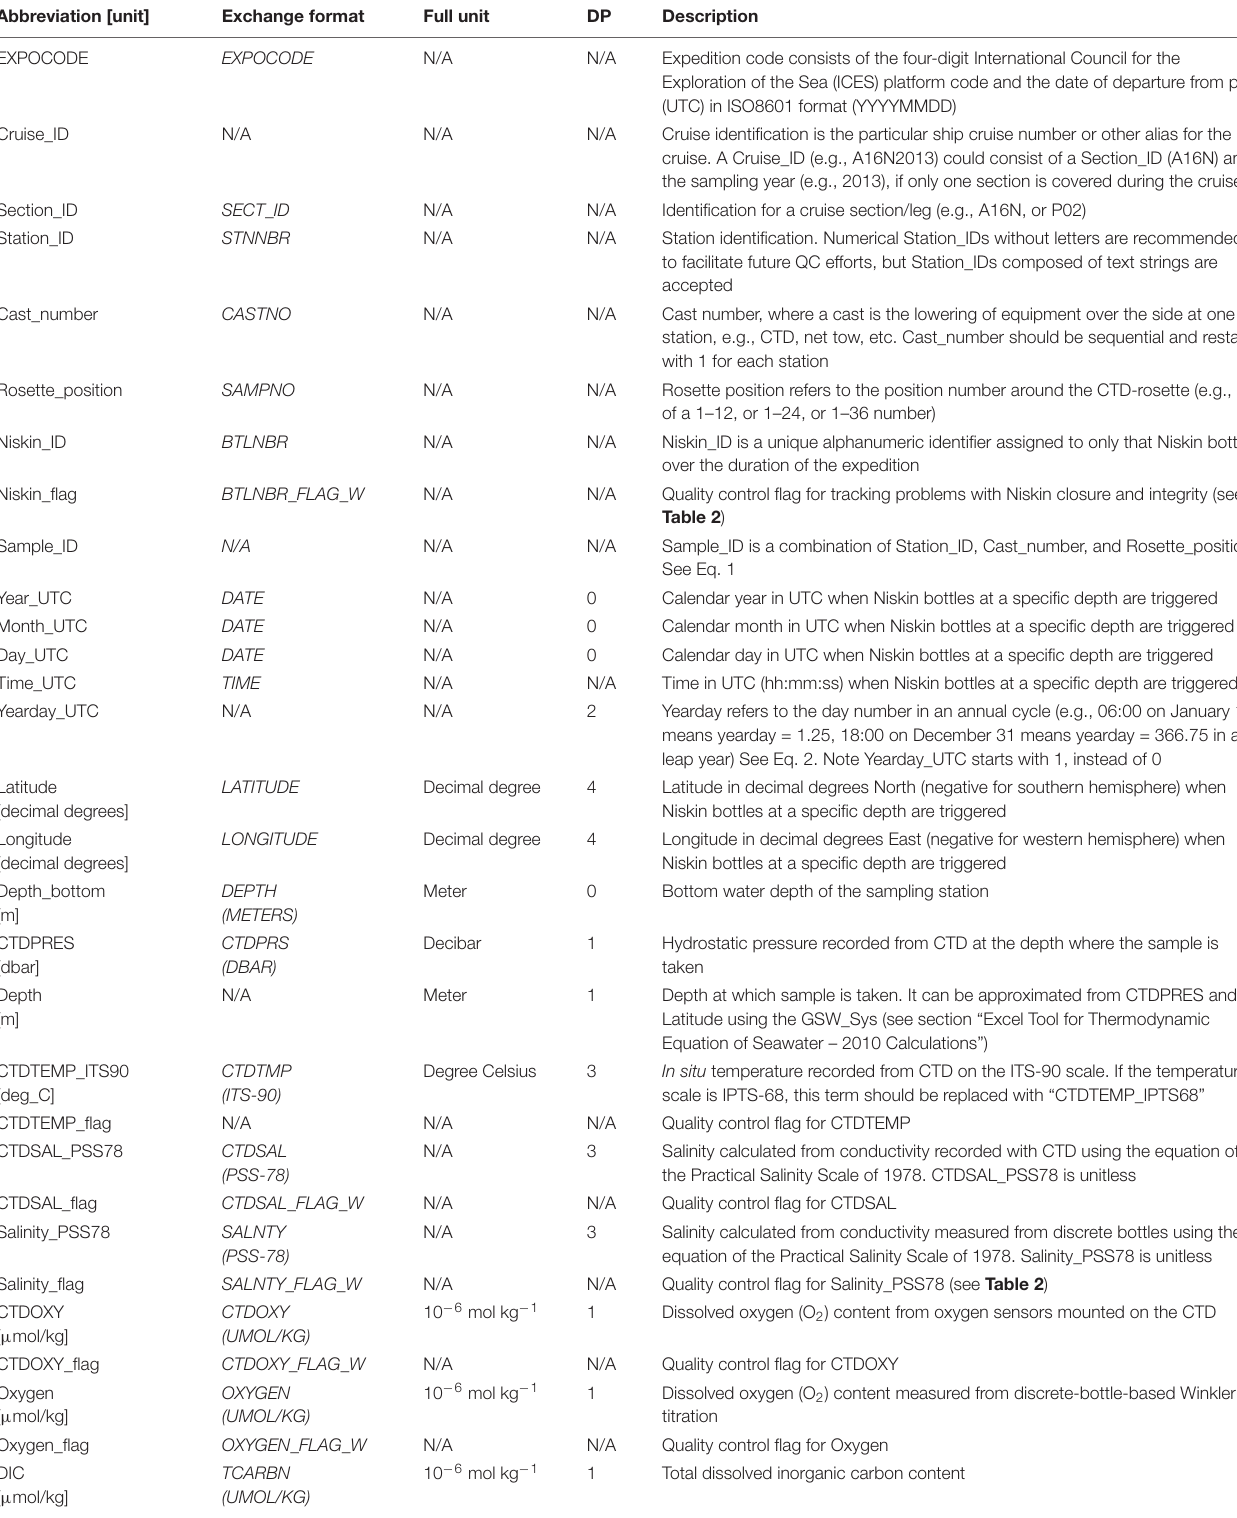
TABLE 1 | Recommended column header abbreviations, their corresponding WOCE Exchange format terms (in italic ), recommended units, and brief descriptions, for discrete chemical oceanographic